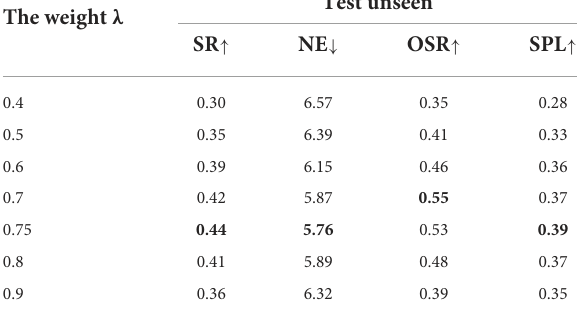
TABLE 2 Comparison of the test unseen